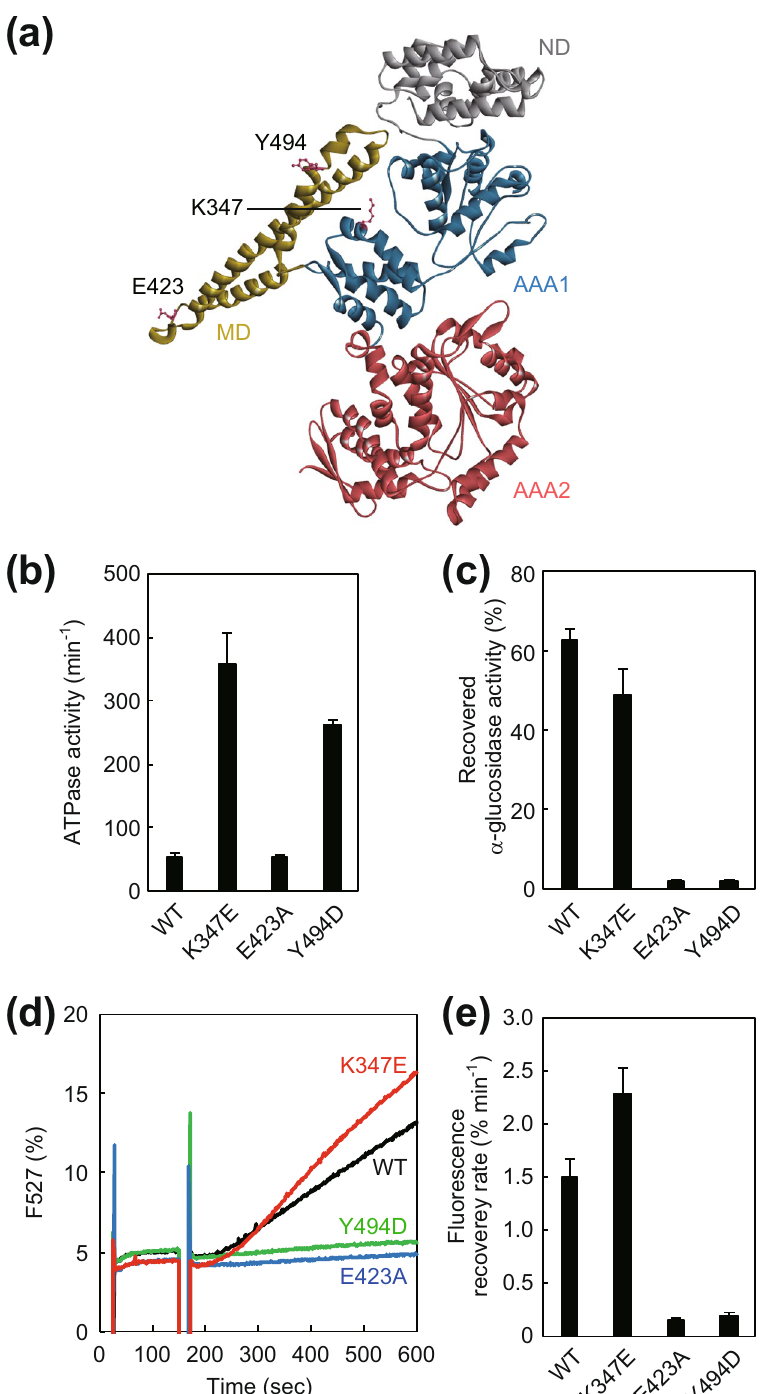
Figure 4. Characterization of hyperactive and repressed mutants of T ClpB. ( a ) Monomeric structure of T ClpB (PDBid:1QVR) 21 is shown. The N-domain (ND), M-domain (MD), AAA1, and AAA2 are colored by gray, yellow, blue, and red, respectively. The mutated residues, Lys347, Glu423, and Tyr494 are shown as sticks. ( b ) ATPase activities of the T ClpB mutants were measured. The experimental procedure was the same as in Fig. 2. ( c ) Disaggregation activities of the T ClpB mutants with T DnaK (0.6 μ M), T DnaJ (0.2 μ M), and T GrpE (0.1 μ M dimer) (termed T KJE) were measured by using α -glucosidase as a substrate. The experimental procedure was the same as in Fig. 3a. The time courses ( d ) and the initial rates ( e ) of the reactivation of heat- aggregated EYFP by the T ClpB mutants with T KJE are shown. The experimental procedure was the same as in Fig. 3b,c. Error bars represent standard deviations of three or more independent measurements. WT,